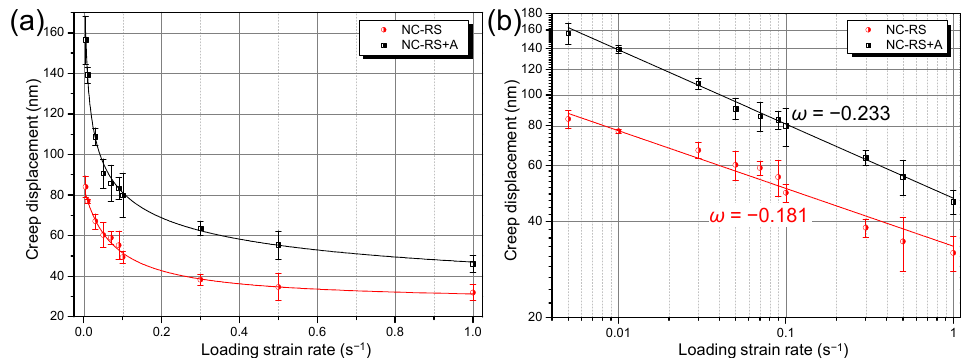
Figure 8. Strain rate dependence of room temperature indentation creep displacements of the NC Mg–Gd–Y–Zr alloys in ( a ) linear and ( b ) double logarithmic coordinate system.